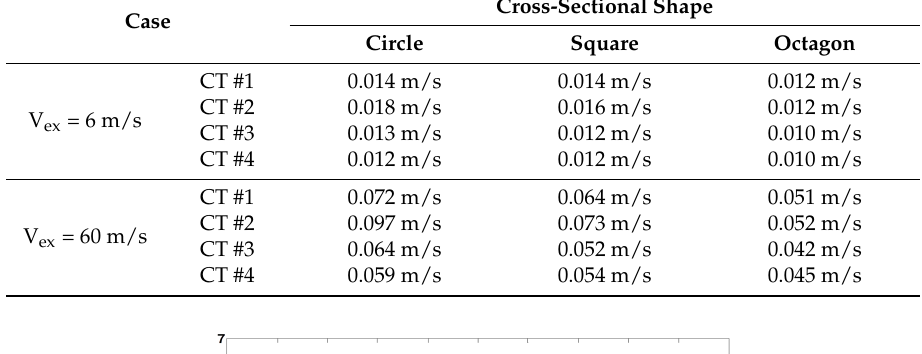
Table 5. Axial velocity standard deviations within core region of investigated contractions.